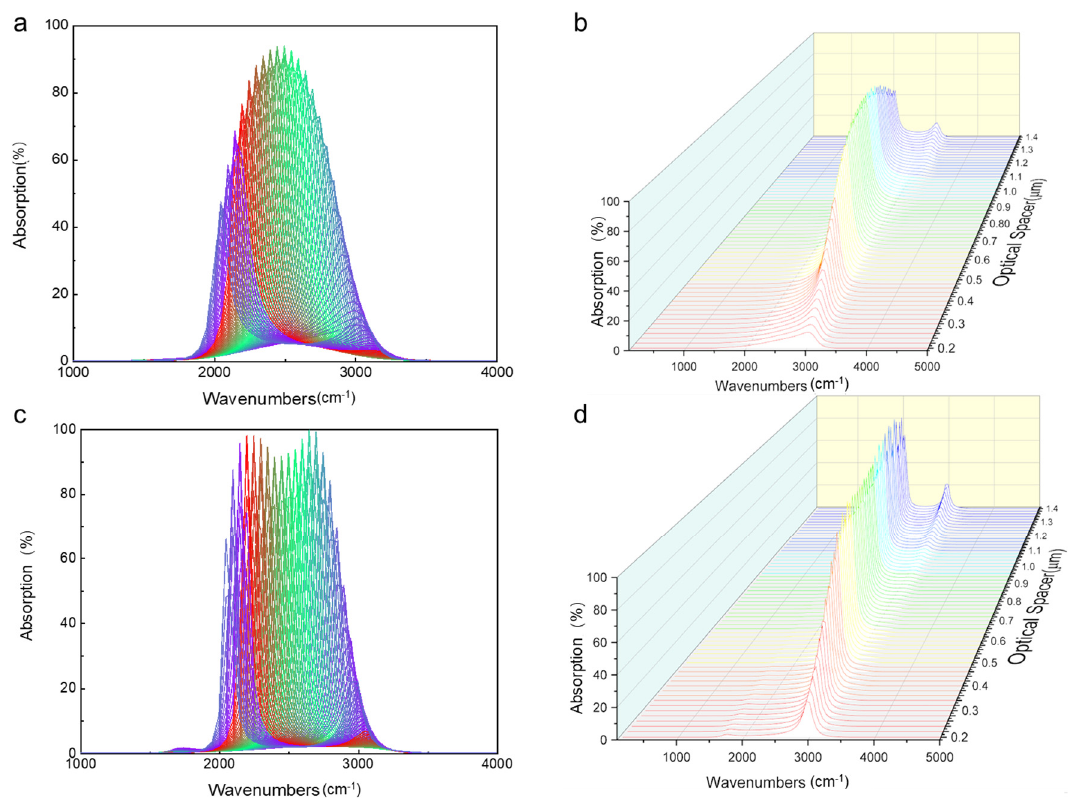
Figure 4. Absorption of the CQD microspectrometer. ( a , b ) Absorption of a CQD microspectrometer with different optical spacer thicknesses with one layer of DBR.( c , d ) Absorption of a CQD microspectrometer with different optical spacer thicknesses and two layers of DBR.